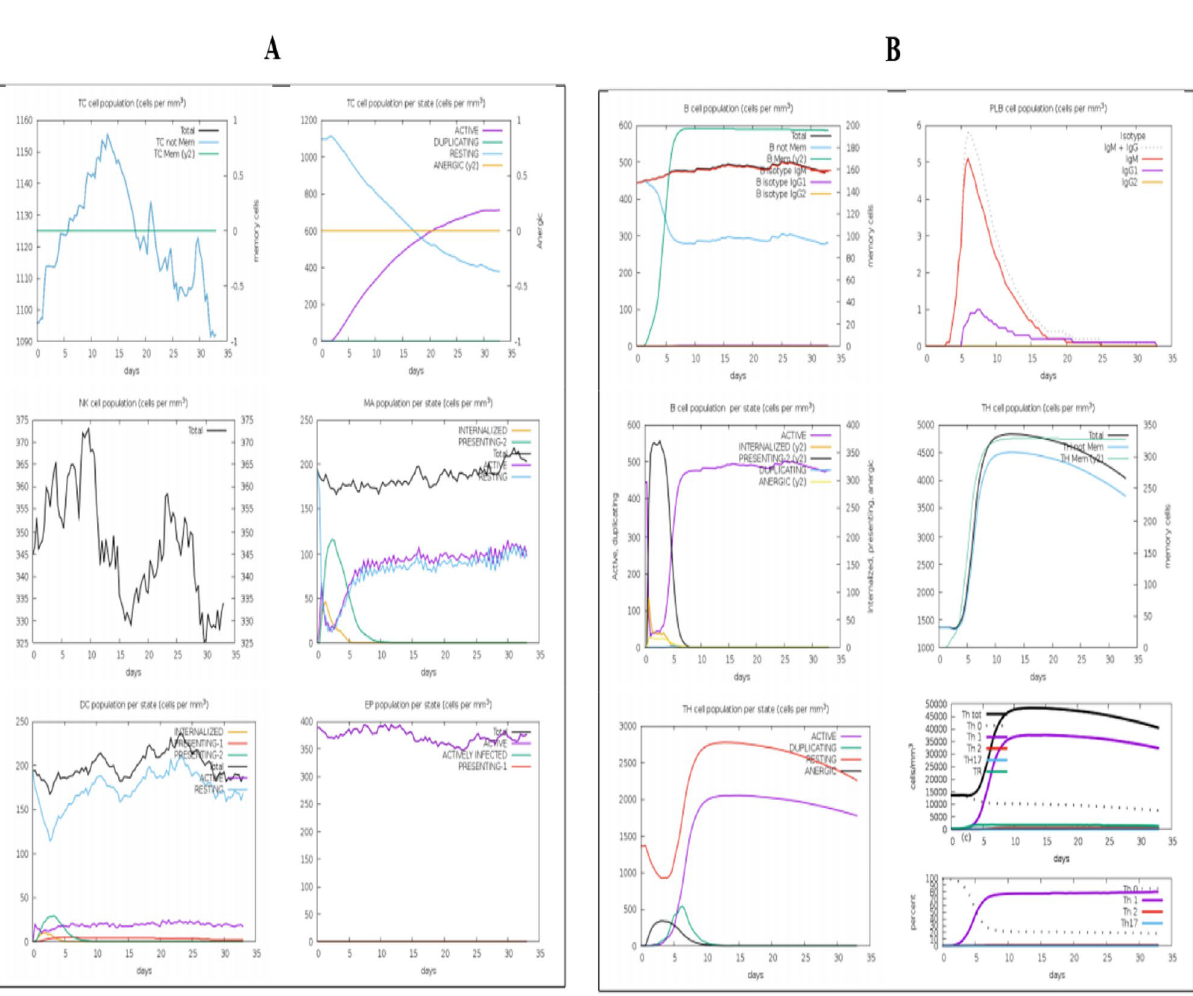
Figure 9. ( A ) Population of B and T cells versus days in response to polyepitope vaccine construct antigen. ( B ) Count of immune cells formed against the response of polyepitope vaccine construct; TC, NK, MA, DC and EP (Cytotoxic T cells, Natural killer cells, Macrophages, Dendritic cells and Epithelial cells).